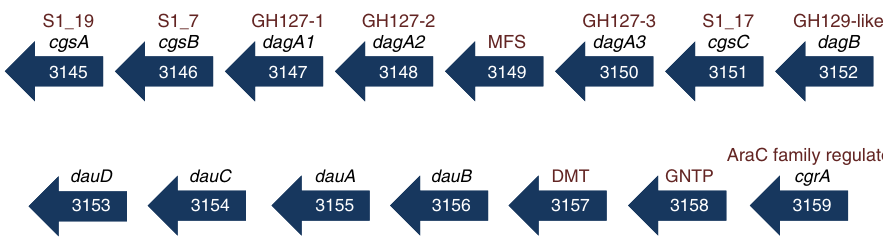
Fig. 1 Z. galactanivorans PUL involved in carrageenan catabolism. Genes are annotated according to their CAZy family (GH127, GH129-like), sulfatase subfamily (S1_19, S1_7, and S1_17) or enzymatic activity. The names of the genes and their functions are given in Table 1. The acronyms for the gene names are as follows: cgs , CarraGeenan Sulfatase; dag , D -3,6-AnhydroGalactosidase; dau , D -3,6-Anhydrogalactose Utilization; cgr , CarraGeenan